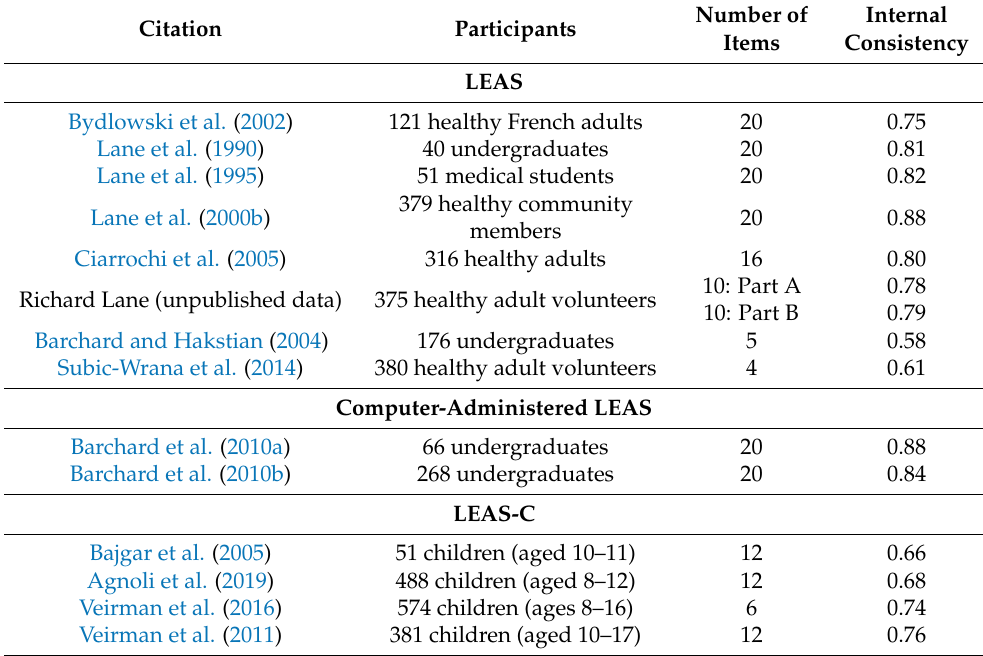
Table 3. Internal consistency reliability of the LEAS, computerized LEAS and children’s version of the LEAS (LEAS-C; (Barchard et al. 2011)).